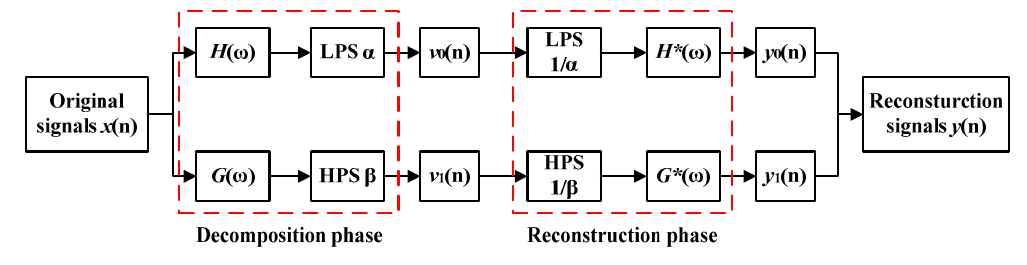
Figure 1. Two-channel filter bank.